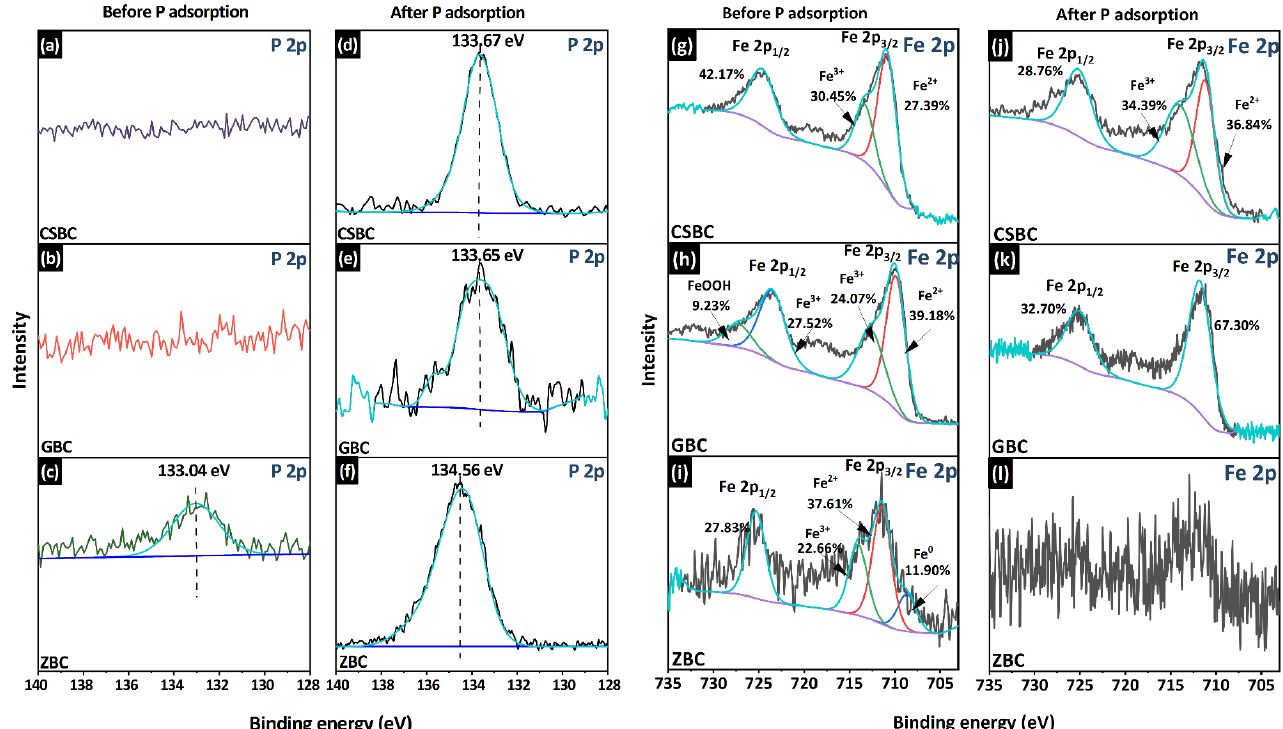
Figure 11. High-resolution XPS spectra of CSBC, GBC, and ZBC: (a − c) P 2p spectra before P adsorption; (d − f) P 2p spectra after P adsorption; (g − i) Fe 2p spectra before P adsorption; and (j − l) Fe 2p spectra after P adsorption.